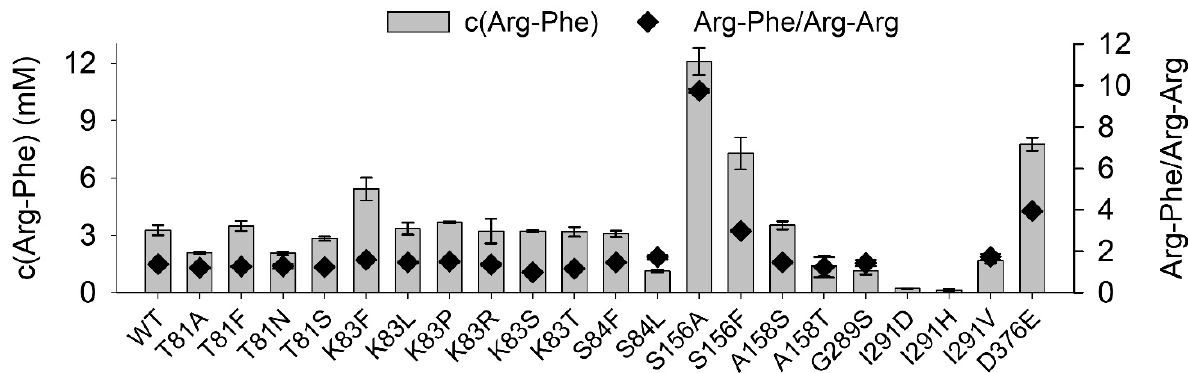
Figure 7. Formation of Arg-Ala and Arg-Arg by the RizA variants. 30 mM of both arginine and alanine and 20 h reaction time at 25 °C. Reactions were set up in triplicates and data is presented as mean ± standard deviation.